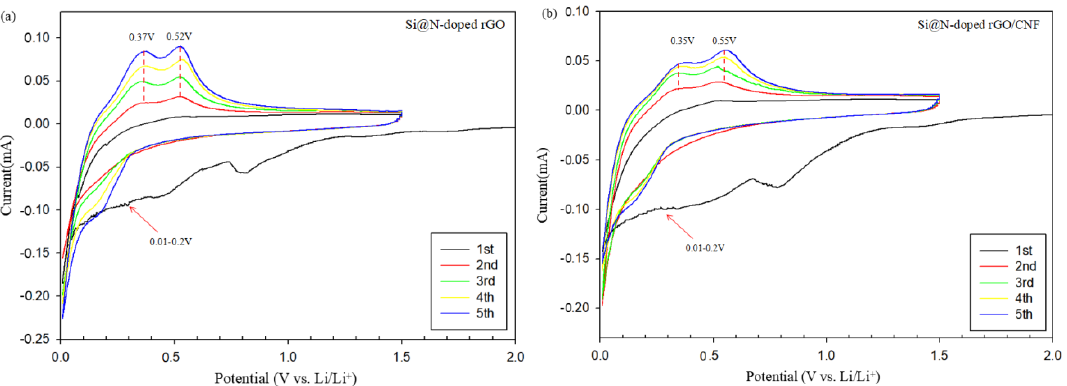
Figure 7. Cyclic voltammetry curves of the synthesized Si@N-doped rGO ( a ) and Si@N-doped rGO/CNF ( b ) electrodes in the initial five cycles.